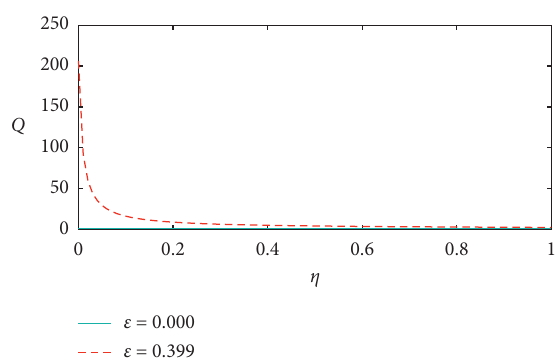
Figure 17: Plots of Mandel’s Q -factor (equation (39)) versus η for th . A � 10, κ � 0 . 8, n � 0 . 15 and for different values of ε . th